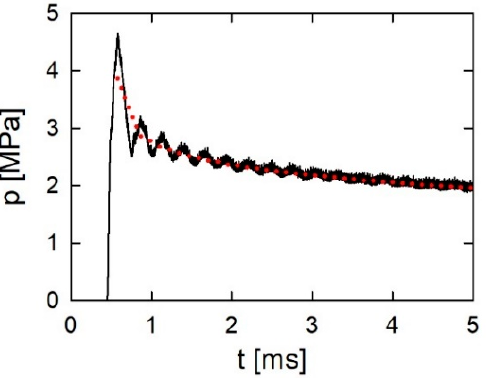
Figure 5. Comparison of recorded (solid line) and smoothed (dotted line) pressure courses. The outflow of the priming mixture combustion products from the primer vent induces an intensive blast wave. Its reflection at the end of the chamber causes a dynamic effect. To take this into account, the dynamic coefficient was assumed to be equal to 2. Thus, the values of p max , before the force value was calculated using Equation (22), were divided by this value. The calculated values of f s for all tests are shown in Figure 6. The horizontal line represents the mean value of 271 kJ/kg. The uncertainty of the mean value for the 95% confidence level is equal to 27 kJ/kg.